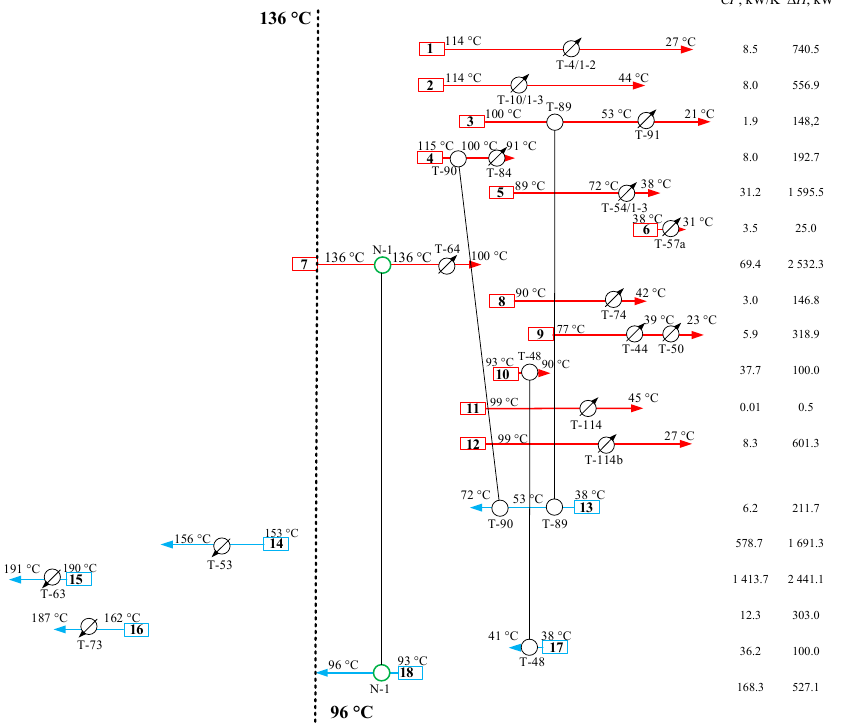
Figure 6. Grid diagram of the retrofit project for the HEN of the EB production unit.